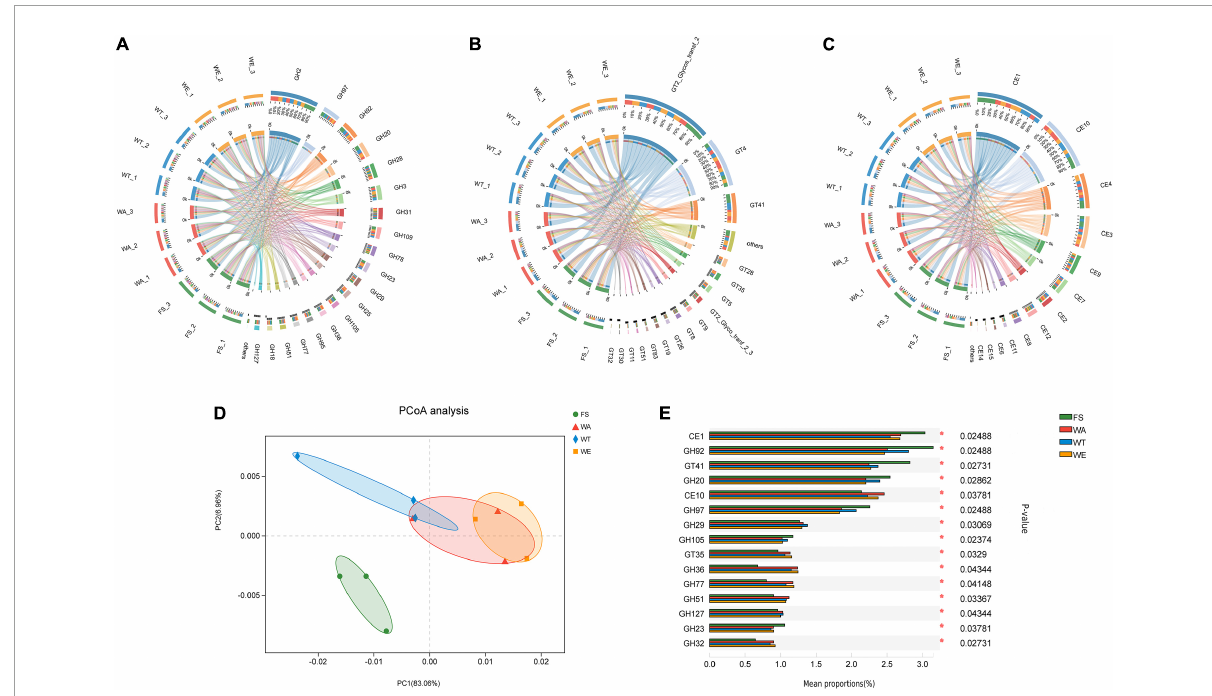
FIGURE4 Composition and variance analysis of CAZymes groups. (A) Distribution and relative abundance of GH family; (B) distribution and relative abundance of GT family; (C) distribution and relative abundance of CE family; (D) CAZymes principal coordinate analysis (PCoA); (E) CAZymes multi-group comparison, the test method is "Tukey-Kramer", the significance level is "0.99", ∗ P < 0.05; ∗∗ P < 0.01; ∗∗∗ P <